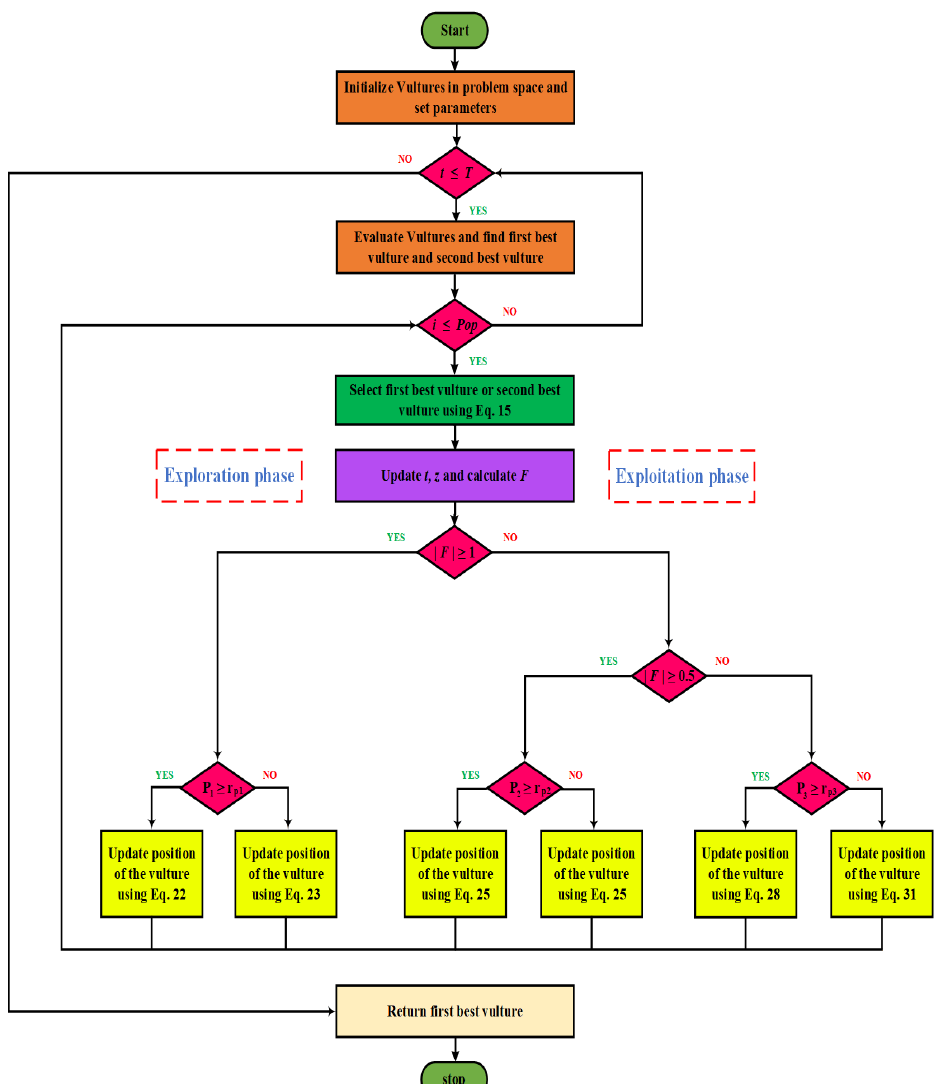
Figure 1. Flowchart for AVOA proposed optimization algorithm.